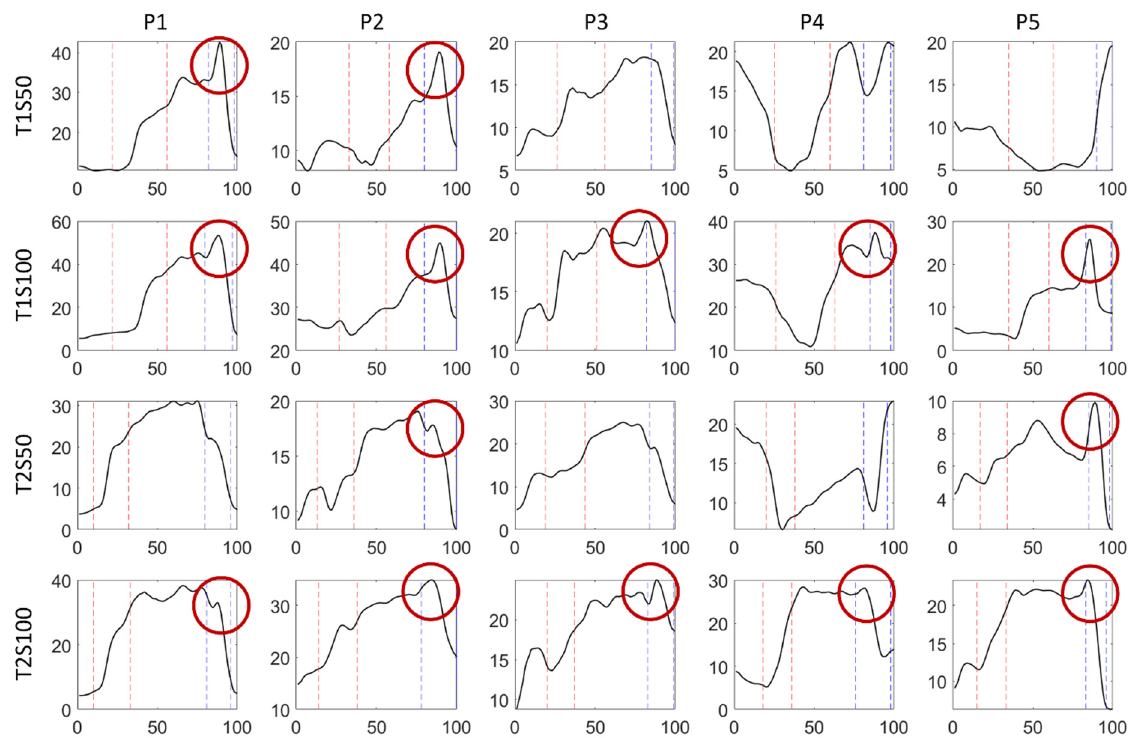
Figure 15. An overview of the interaction force ( y -axis in N, x -axis in%-Cycle) between the arm and armrest. Two red dashed lines enclose the arm lifting phase, while two blue dashed lines bound the arm lowering phase. The red circles highlight the peaks of the interaction forces, which were observed at the beginning of the arm lowering phase.